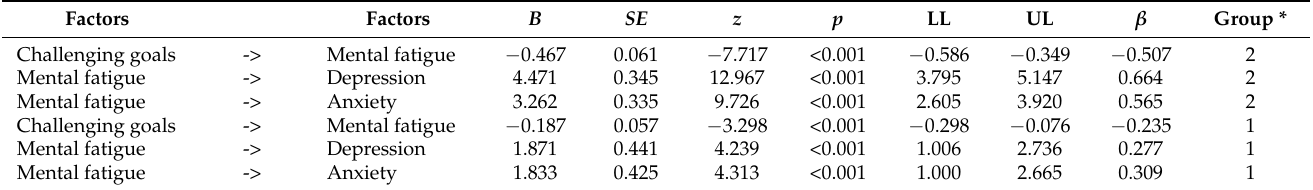
Table 18. Results of structural equation modelling of challenging goals, mental fatigue, depression, and anxiety in groups of participants and non-participants of e-learning-based computer programming courses.